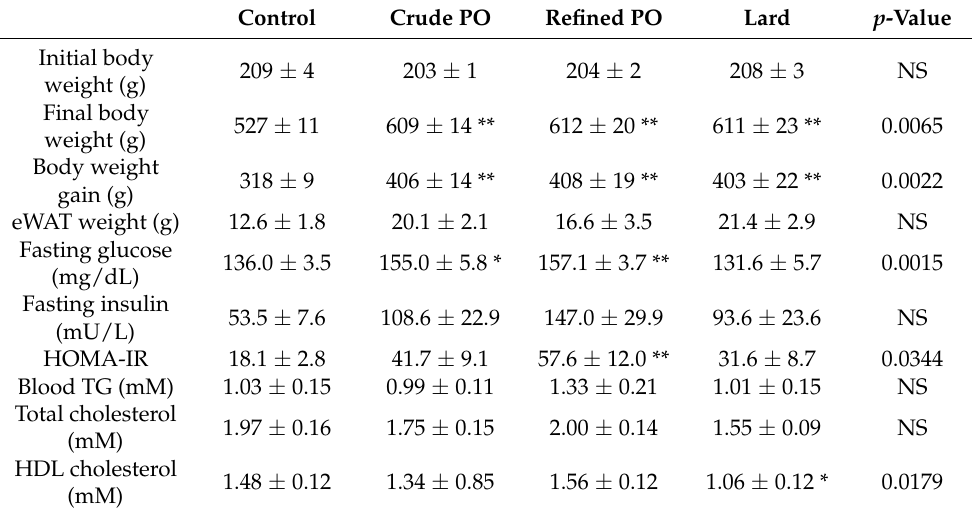
Table 1. Body weight, glucose homeostasis and blood